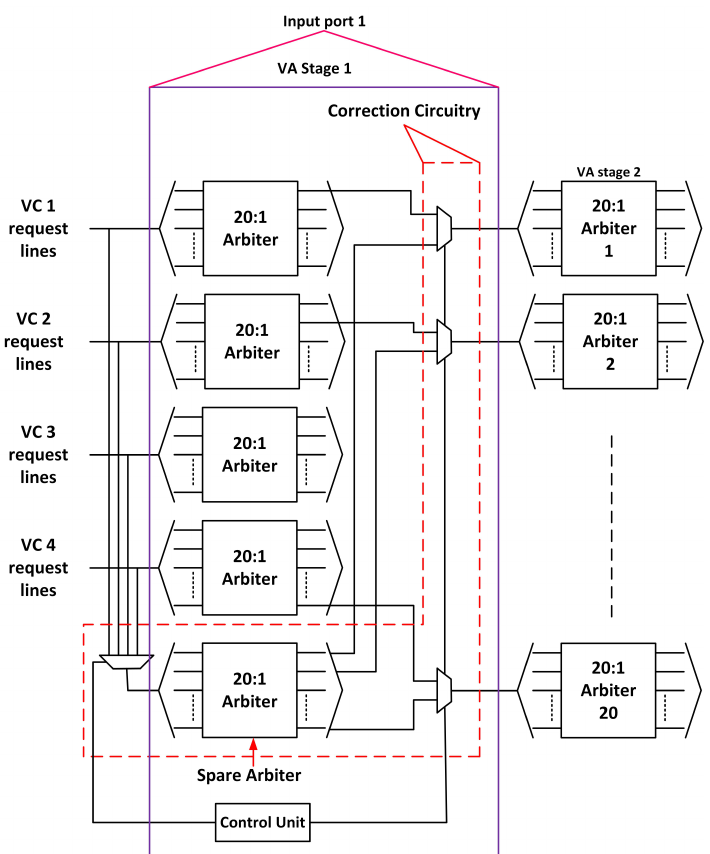
Figure 6. Virtual channel allocation stage 1 (VA1) fault-tolerant design.